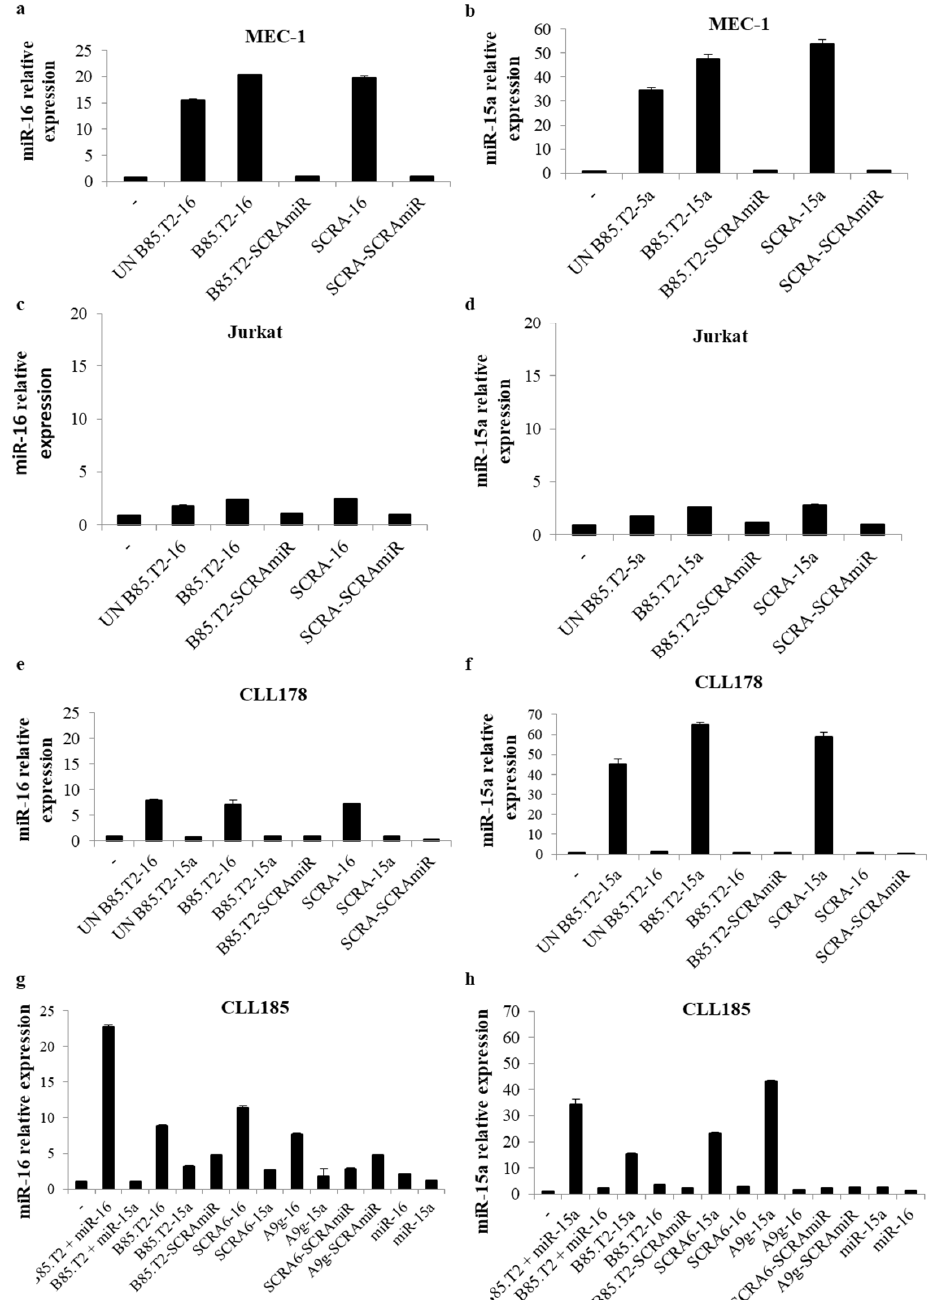
Figure 5. Aptamer miRNA delivery into CD19 + continuous and primary leukemic cells. ( a , b ) MEC-1 cells were treated with indicated molecules (400 nM) for 24 h. Then, cell culture medium was replaced with fresh medium without aptamers or conjugates and grown for an additional 24 h. MiR-16 ( a ) and miR-15a ( b ) levels were evaluated by qRT-PCR. U6 RNA was used as a reference gene. miRNA expression relative to cells treated with a control conjugate (SCRA-SCRAmiR) is reported in the graphs. Error bars show the mean ± SD values on technical replicates. ( c , d ) Jurkat cells were treated with indicated molecules (400 nM) for 24 h. Then, cell culture medium was replaced with fresh medium without aptamers or conjugates and grown for additional 24 h. miR-16 ( c ) and miR-15a ( d ) levels were evaluated by qRT-PCR. U6 RNA was used as a reference gene. miRNA expression relative to untreated cells is reported in the graphs. Error bars show the mean ± SD values on technical replicates. — (untreated cells); UN B85.T2-16 (unconjugated chimera B85.T2-miR-16); B85.T2-16 (chimera B85.T2-miR-16); B85.T2-SCRAmiR (control chimera with B85.T2 aptamer conjugated to a scrambled miR); SCRA-16 (control chimera with a control aptamer stick conjugated to miR-16); SCRA-SCRAmiR (control chimera with a control aptamer stick conjugated to a scrambled miR); UN B85.T2-15a (unconjugated chimera B85.T2-miR-15a);